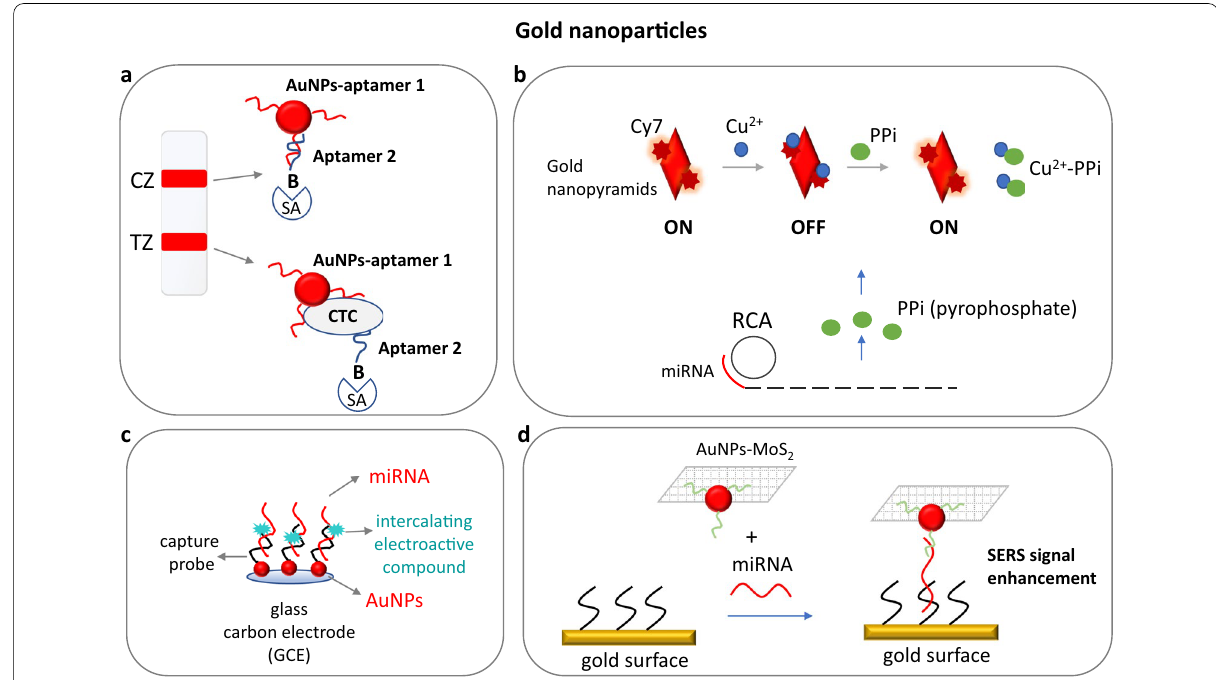
Fig. 1 a An aptamer-AuNPs strip biosensor for visual detection of circulating tumor cells (CTCs). b Silica-coated gold nanobipyramids in combination with the fluorescent dye Cy7, which fluorescence is quenched by Cu 2 + ions and recovered by pyrophosphates (PPi) that are produced during rolling circle amplification (RCA) reaction triggered by miRNA target. c an electrochemical detection of miRNA captured onto an electrode by deposited AuNPs-DNA. The signal is generated by an intercalating redox dye. d AuNPs decorated with molybdenum sulfide (MoS 2 ) nanosheets are used for surface-enhanced Raman spectroscopy (SERS) signal enhancement in miRNA analysis. AuNPs gold nanoparticles, TZ test zone, CZ control zone, SA streptavidin, B